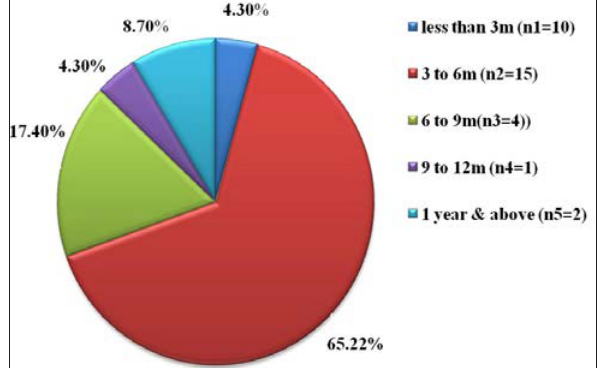
Figure-4: Age wise analysis of positive